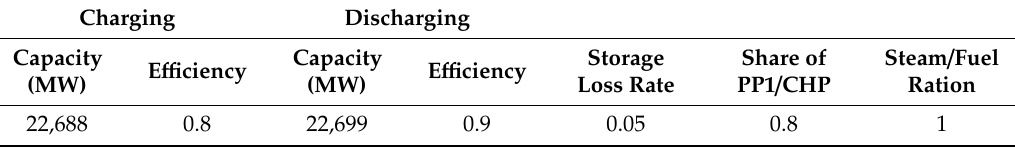
Table 4. Parameters for Rockbed Storage.